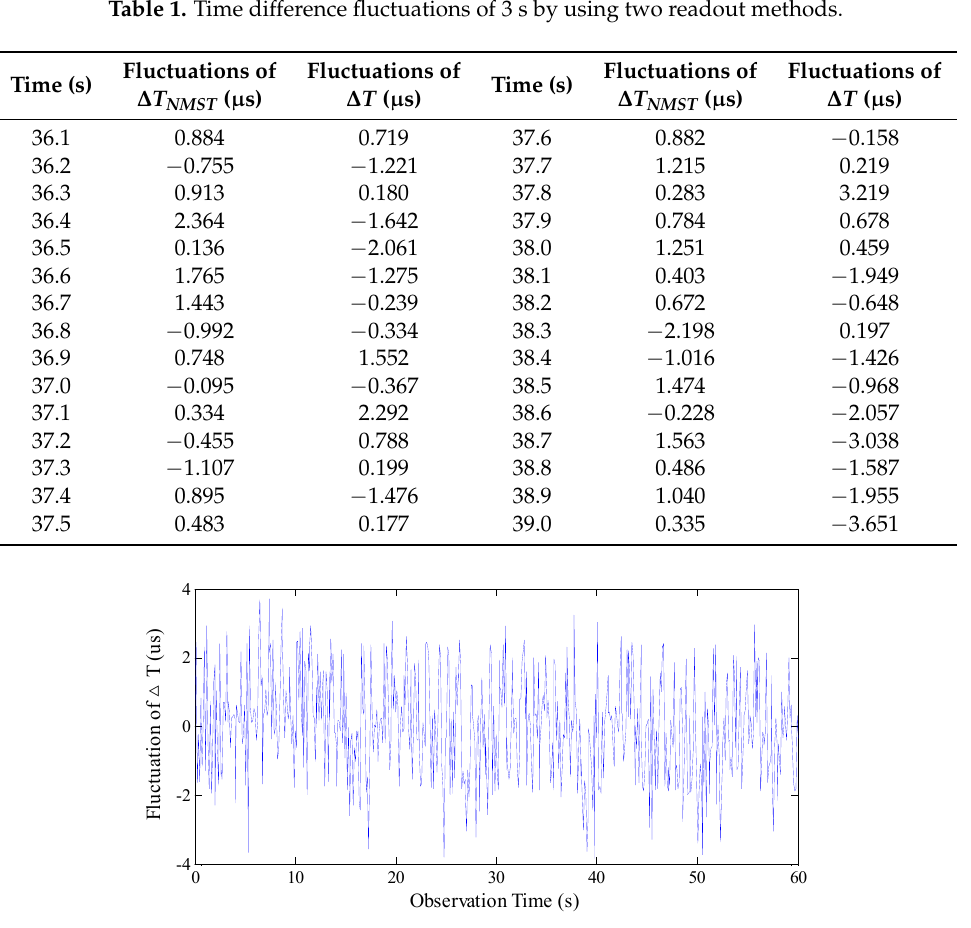
Figure 14. The fluctuation of Δ T by using the BMSTD readout scheme.